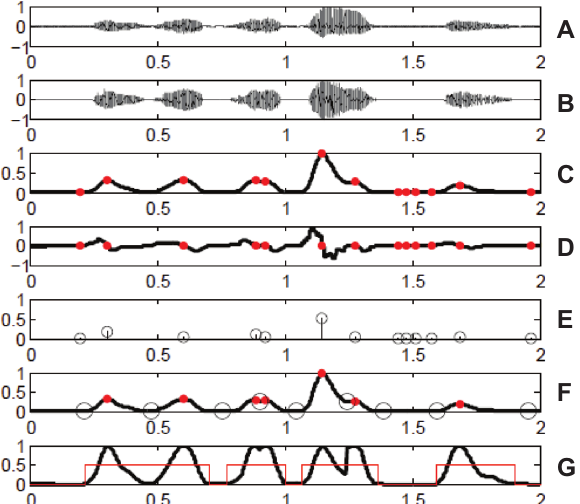
Figure 3. Enhancement of High-Energy Regions: (A) Original Clean Speech, (B) CIMF, (C) Frame Energy, (D) First-Order Difference, (E) Slope Values Computed at Each Peak Locations, (F) Loca- tion of Peaks and Valleys, and (G) Enhanced Energy